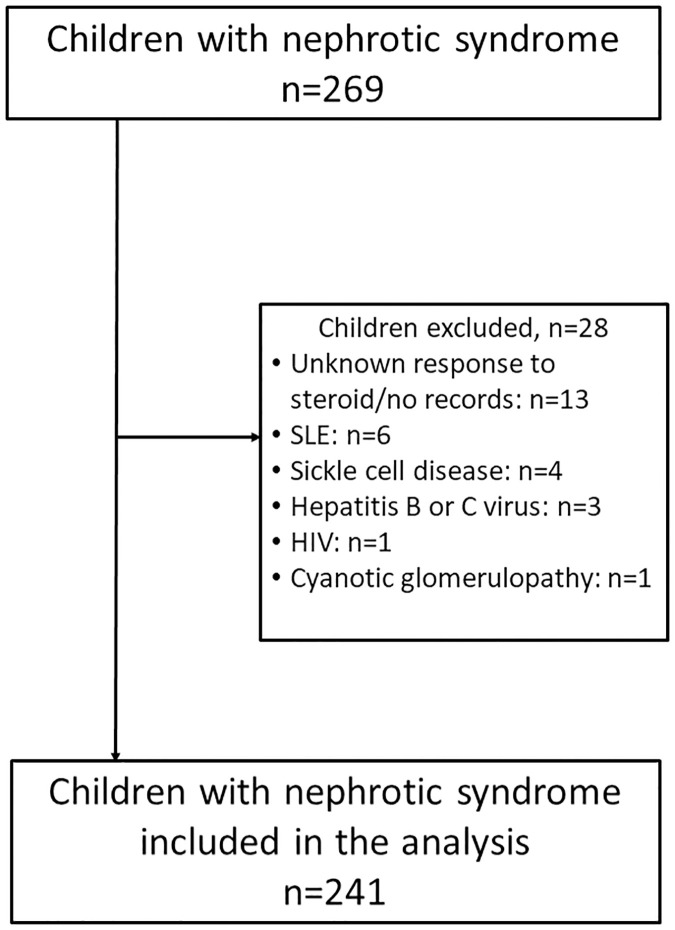
Flow diagram of study participants.